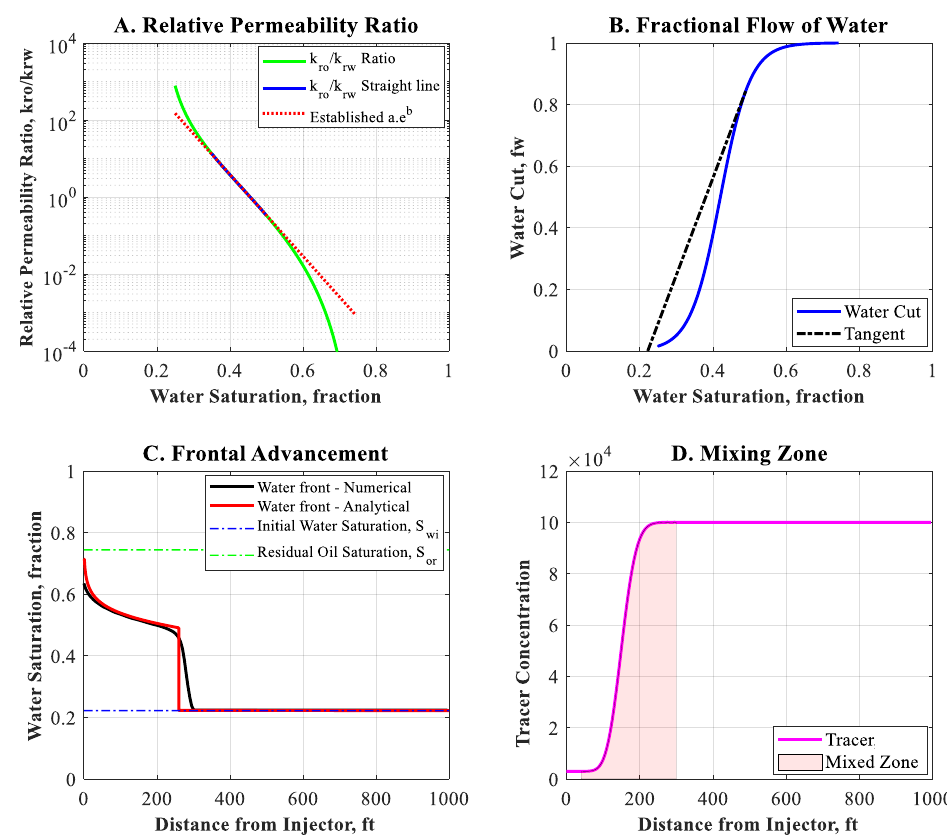
Figure A1. Water frontal in the 1D grid model. ( A ) The established exponential relationship between the relative permeability ratio (logarithmic value) and water saturation. ( B ) Water cut (f w ) and the plotted tangent line. ( C ) Comparison of the analytical solution and numerical solution for the waterfront distance after 462 days. ( D ) Tracer concentration mixing curve after 462 days illustrating the tracer concentration of the injected water of 3000 and the tracer concentration of the connate water of 100,000 to emulate the low salinity water injection in the reservoir. Appl. Sci. 2020 , 10 , x